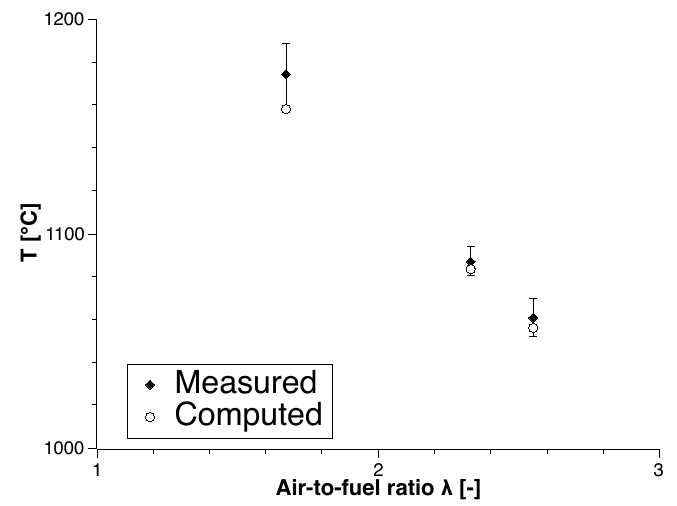
Figure 20. Comparison between the exhaust gases temperature ( ◦ C) measured and the one predicted with the numerical model for different values of air-to-fuel ratios and different air inlet temperatures.